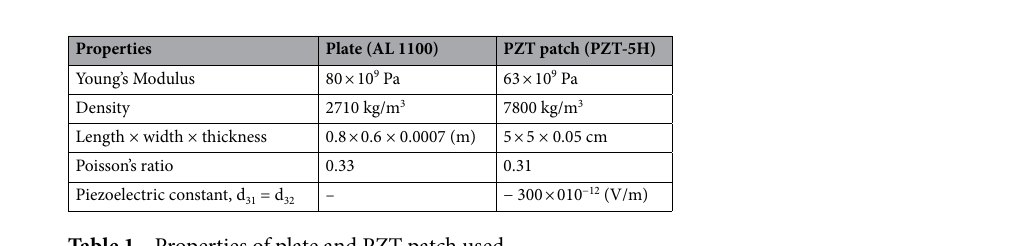
Table 1. Properties of plate and PZT patch